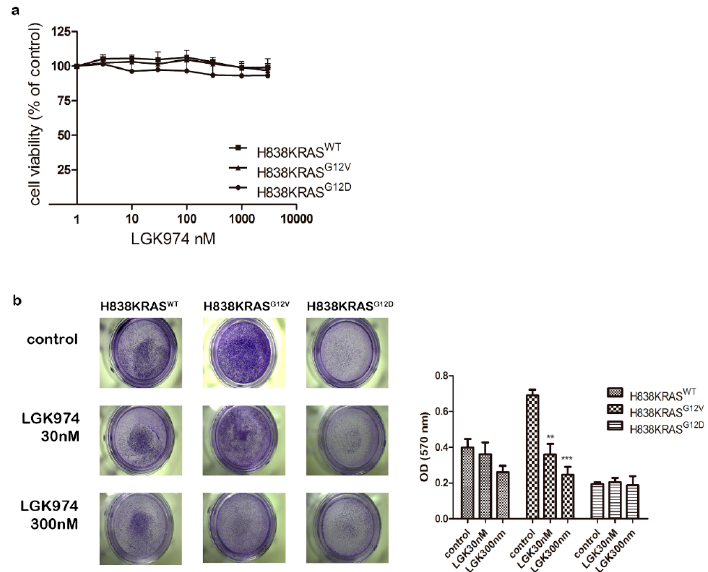
Figure 7. The Wnt inhibitor LGK974 suppress the migration ability of H838KRAS G12V cells. ( a ) The cell viability assays of H838KRAS isogenic cells after treating with LGK974. ( b ) The migration assays of H838KRAS isogenic cells after treating with no LGK974 (control), 30 nM LGK974 and 300 nM LGK974. The OD ratio of crystal violet was measured. The values represent the means ± s.d. of five independent assays ( n = 5, ** p < 0.01 and *** p <